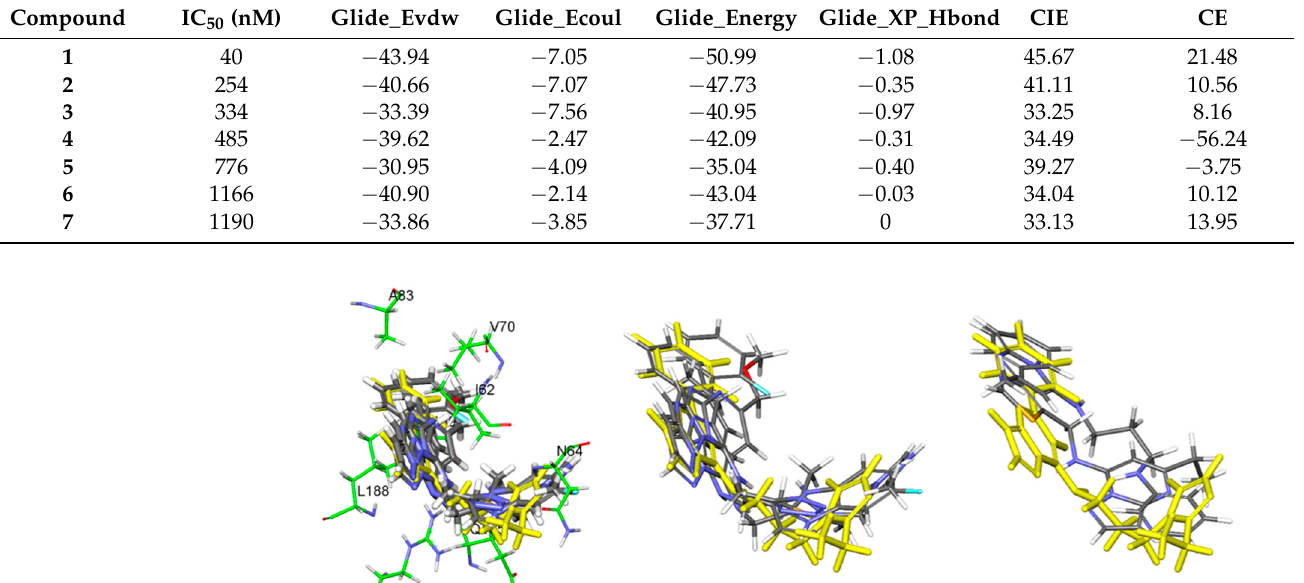
Table 2. Binding energy scores of Glide, negative CDOCKER energy (CE), negative CDOCKER interaction energy (CIE) obtained from molecular docking simulations for hit derivatives.